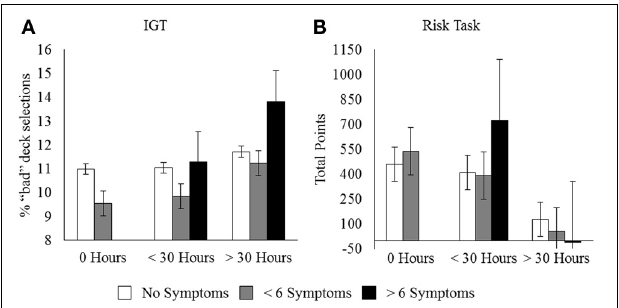
FIGURE 2 | (A) Proportion of trials on which the “bad” decks were selected in the IGT and (B) total points earned in the risk task as a function of Hours and PVP symptoms. Error bars represent standard error of the mean.